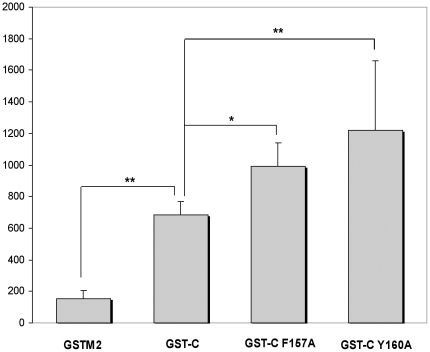
Effect of substitution mutations within the GSTM2 α-6 helix upon
cellular translocation of the C-terminal domain (GST-C).L-929 cells were treated for 2 hours with 200 nM Oregon Green-labelled
GST-C variants and GST-C wildtype. The mean cellular fluorescence of
each sample was normalised for the degree of fluorescent labeling of
that protein. Data represents the average of four to six independent
experiments ± SEM. Significantly changed translocation efficiency
(as determined by student's paired t-Test; one-tailed) is indicated
by an asterisk (* = P<0.05;
** = P<0.01).